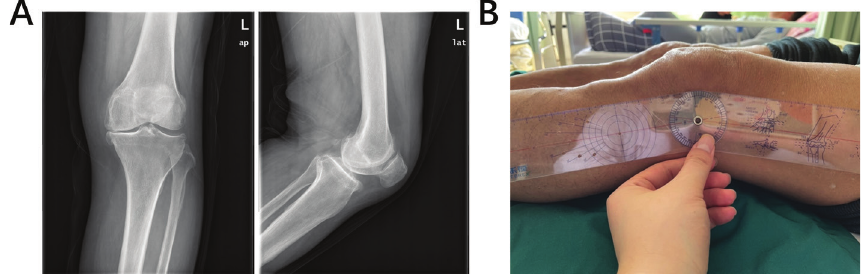
Fig. 1 . (A) Preoperative anteroposterior and lateral radiographs of knee joint. (B) Flexion contracture of the